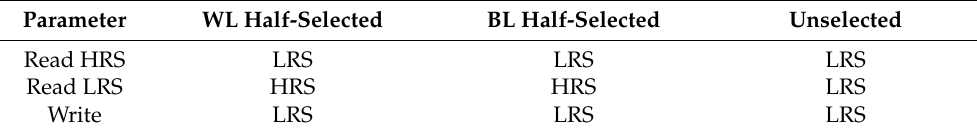
Table 2. Worst-case cell